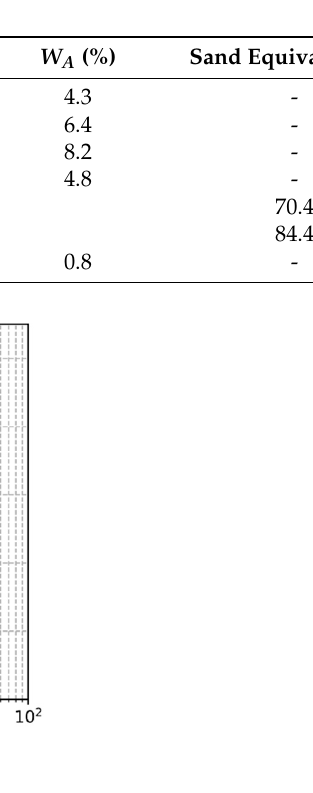
Table 1. Physical properties of aggregates.